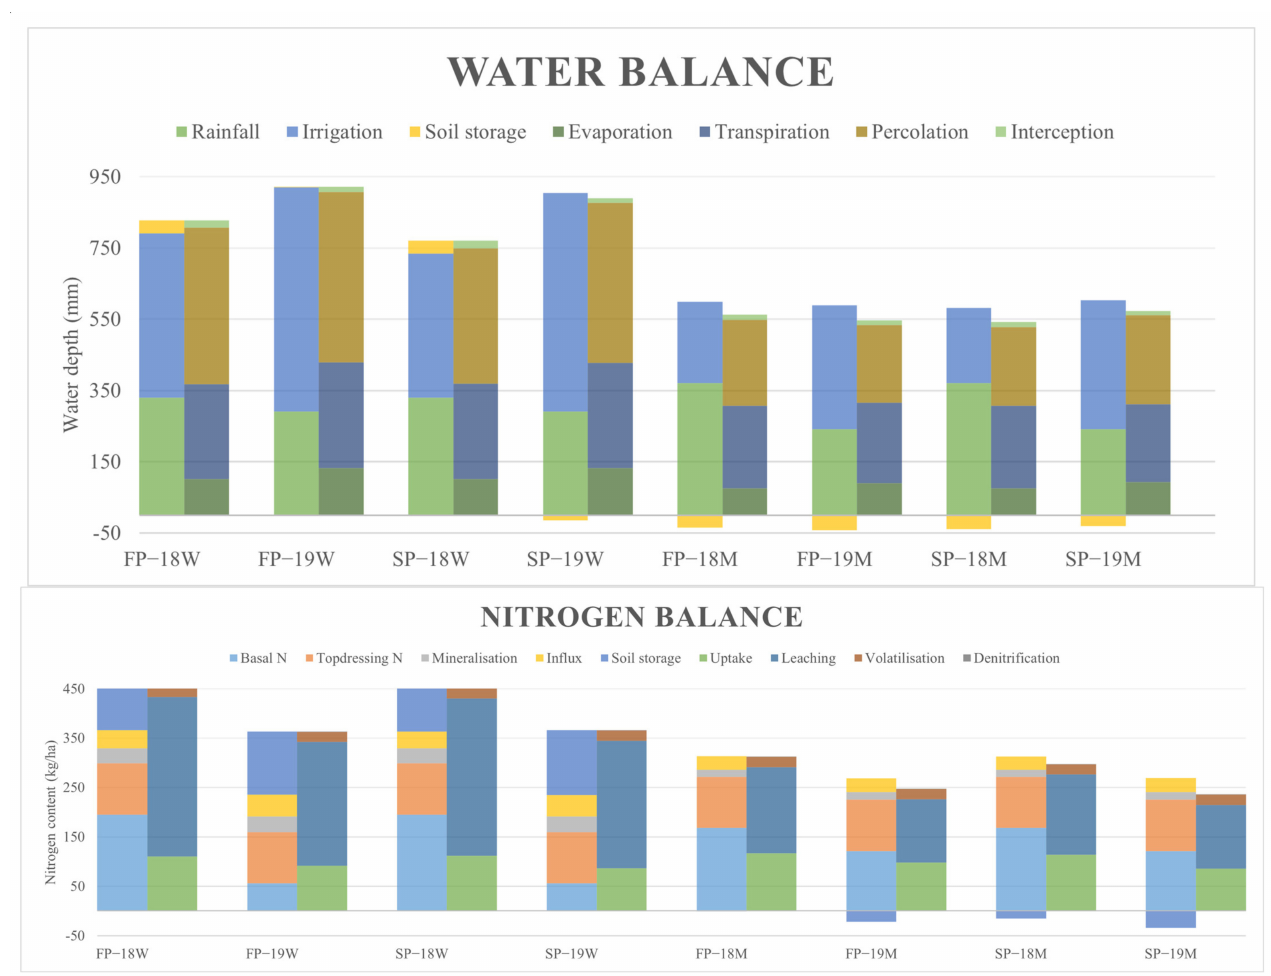
Figure 5. Water and nitrogen budgets for experimental treatments in the wheat and maize seasons in 2018 and